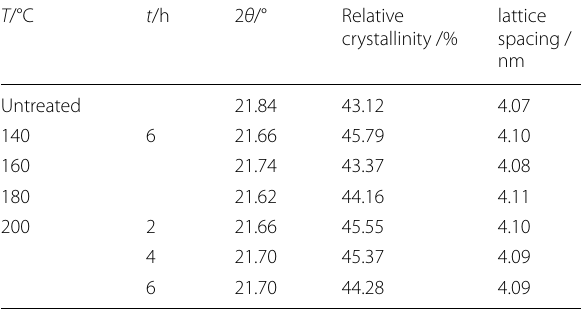
Table 3 The 2 θ , relative crystallinity and lattice spacing of untreated and oil heat-treated bamboo